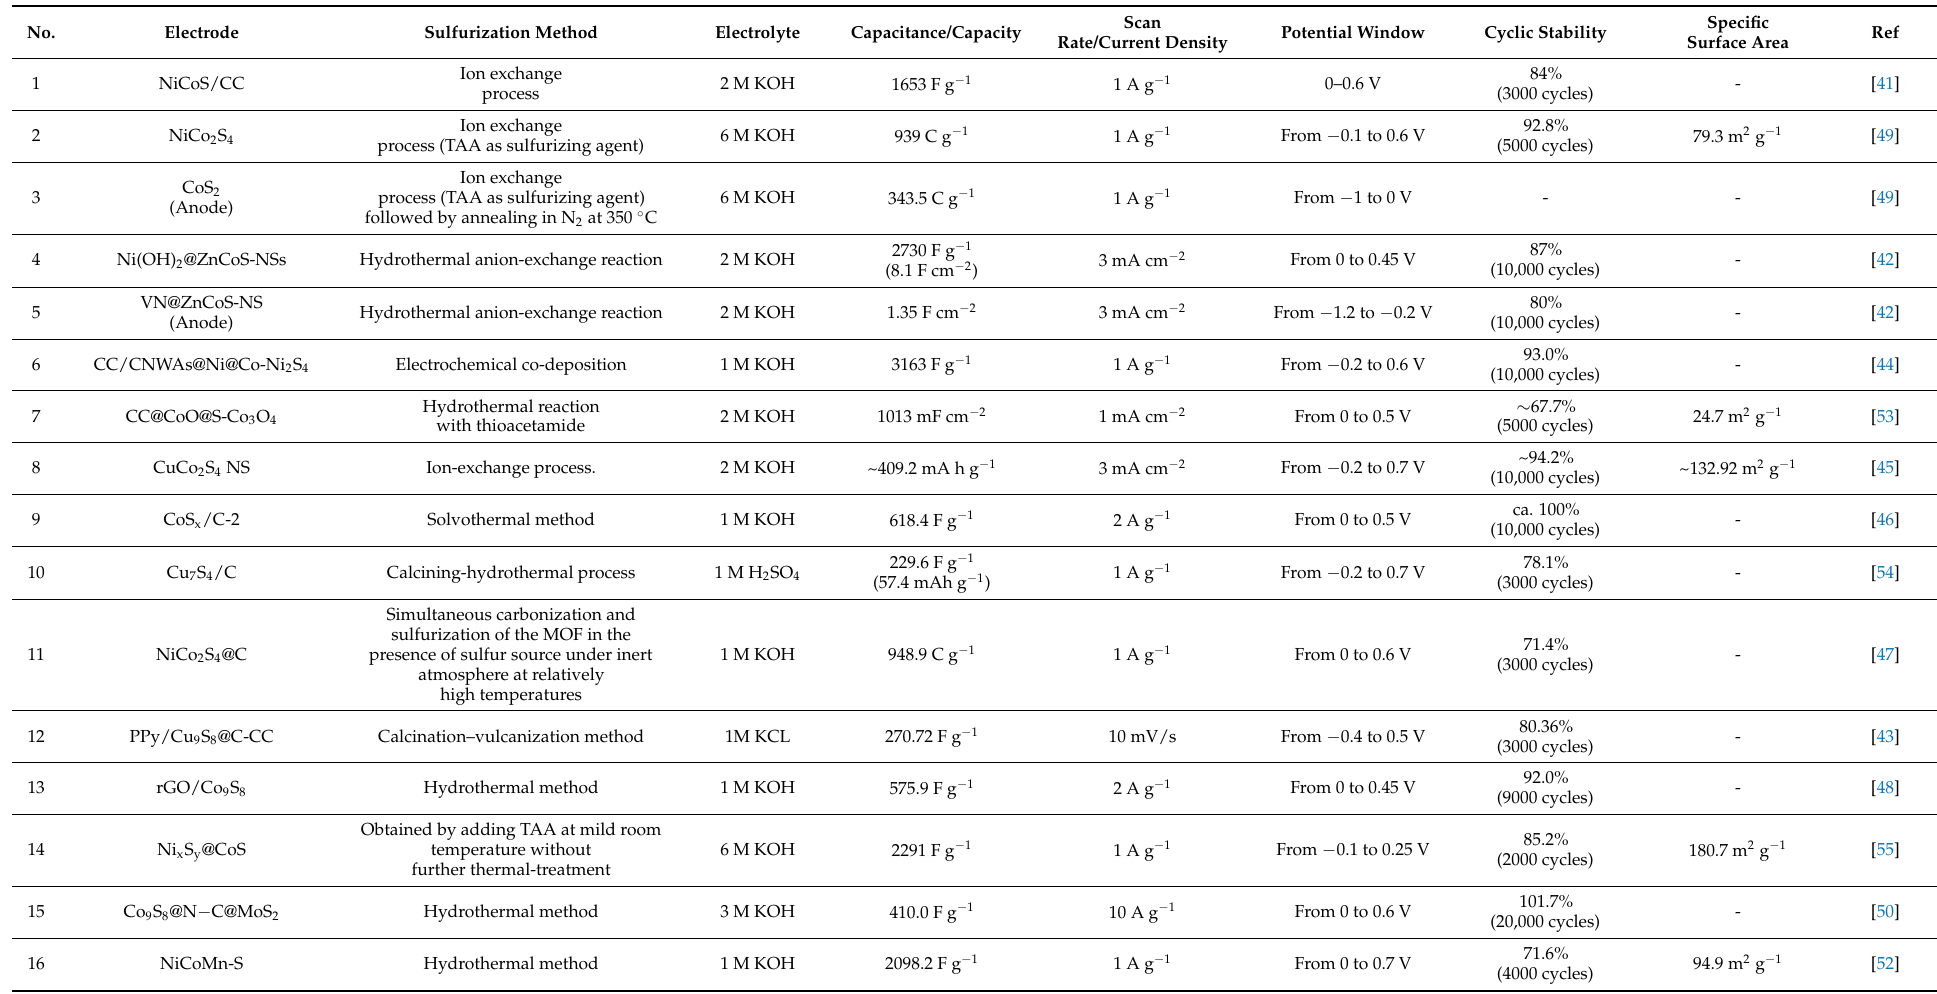
Table 1. Summary of the electrochemical parameters of the sulfurized MOF-based electrodes in three-electrode measurement systems for supercapacitor